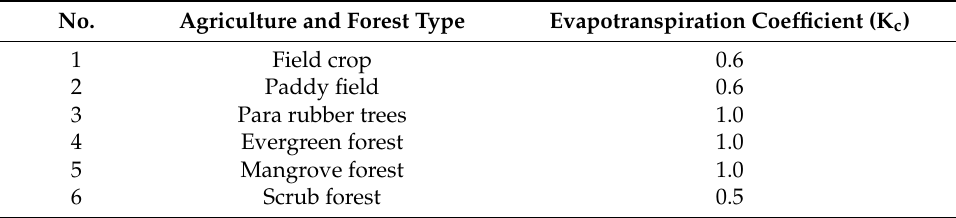
Table A1. The evapotranspiration coefficient (Kc) of each agriculture and forest type.